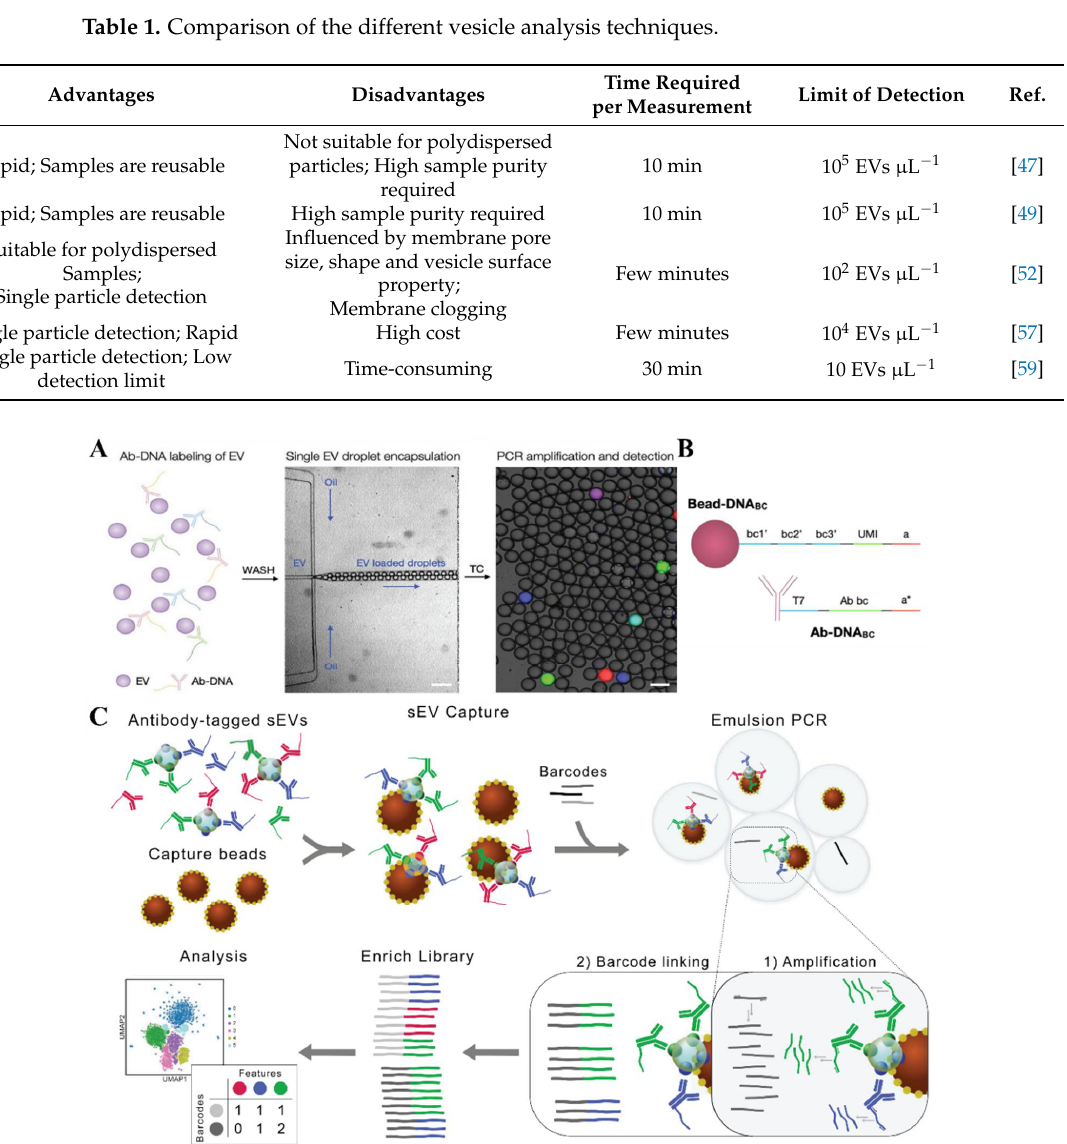
Figure 9. Droplet digital technique for the single EV molecular analysis. ( A ) Schematic of the droplet-based single EV detection. Labeled EVs are detected in the form of fluorescent